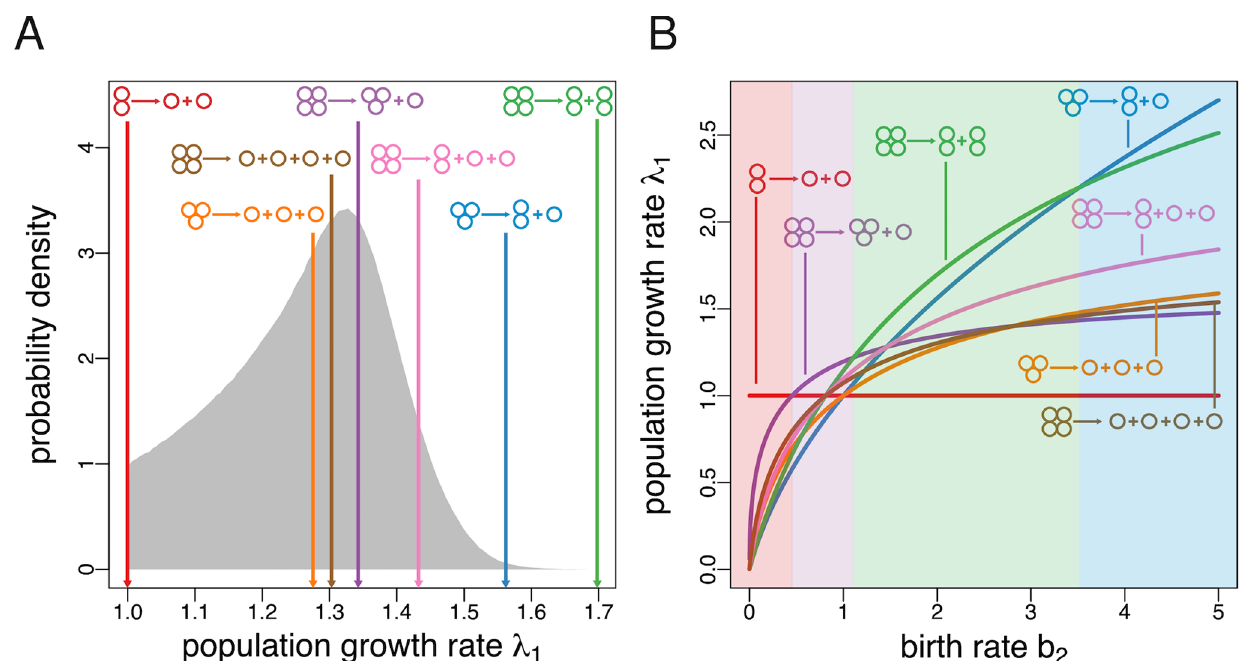
Fig 2. The optimal fragmentation mode is pure and characterised by binary fragmentation. A Mixed fragmentation strategies are dominated. Here we show the empiricalprobabilitydistribution of the growth rate of mixed fragmentation modes for n = 4 (generatedfrom a sample of 10 7 randomly generated fragmentation modes) subject to the fitness landscape{ b , d } = {(1, 2, 1.4), (0, 0, 0)}. The growth rates of all seven pure fragmentation modes for n = 4 are indicatedby arrows. In this case, 2+2 achievesthe maximal possiblegrowth rate amongall possiblefragmentation modes. B Optimal fragmentation modes are characterised by binary splitting. Populationgrowth rate ( λ 1 ) for all seven pure fragmentation modes for n = 4 subject to the fitness landscape{ b , d } = {(1, b 2 , 1.4), (0, 0, 0)} as a function of the birth rate of groupsof size 2, b 2 . Each of the four fragmentation modes characterised by binary fragmentation (1+1, 2+1, 2+2, and 3+1) can be optimal dependingon the value of b 2 . Contrastingly, nonbinaryfragmentation modes (1+1+1, 1+1+1+1, and 2+1+1) are never optimal.